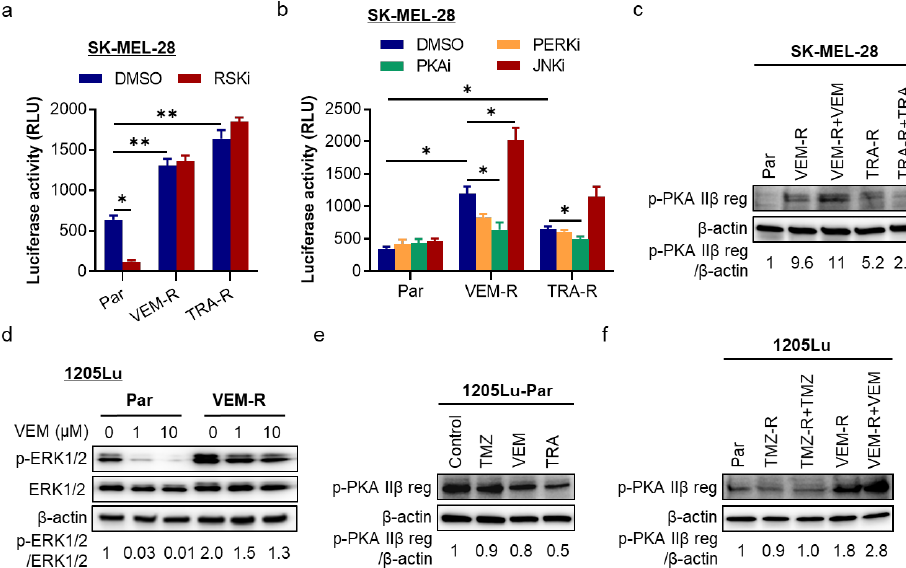
Figure 4. Effects of inhibiting RSK and protein kinase A (PKA) on NLRP1 gene promoter activity in drug-resistant cells. ( a ) NLRP1 promoter luciferase activity in parental, VEM-resistant (VEM-R), and TRA-resistant (TRA-R) SK-MEL-28 cells treated with DMSO or 10 µ M BI-D1870 (RSKi) for 24 h. ( b ) NLRP1 promoter luciferase activity in parental and resistant SK-MEL-28 cells treated with DMSO, 1 µ M GSK2606414 (inhibitor of the stressor protein kinase R-like ER kinase, PERKi), 5 µ M H 89 2HCl (inhibitor of PKA, PKAi), or 10 µ M SP600125 (inhibitor of c-Jun N-terminal kinase, JNKi) for 24 h. ( c ) Western blot analysis of PKA II β regulatory subunit (PKA II β reg) phosphorylation in VEM-R and TRA-R SK-MEL-28 cells treated with VEM or TRA for 24 h as described in Figure 3c. ( d ) VEM-R 1205Lu cells were generated, indicated by reactivation of ERK1/2 phosphorylation. ( e ) Western blot analysis of PKA II β reg phosphorylation in parental 1205Lu cells treated with different drugs for 24 h as described in Figure 1c. ( f ) Western blot analysis of PKA II β reg phosphorylation in parental, TMZ-resistant (TMZ-R), and VEM-R 1205Lu cells treated with DMSO as control, 100 µ M TMZ, or 5 µ M VEM for 24 h. In ( c – f ), the band densities of p-PKA II β reg and p-ERK1/2 were quantitated and normalized to those of the corresponding loading control β -actin ( c , e , f ) or total ERK1/2 ( d ). Representative images are shown and data expressed as the mean ± SEM, n = 3. * p < 0.05 and ** p < 0.01.